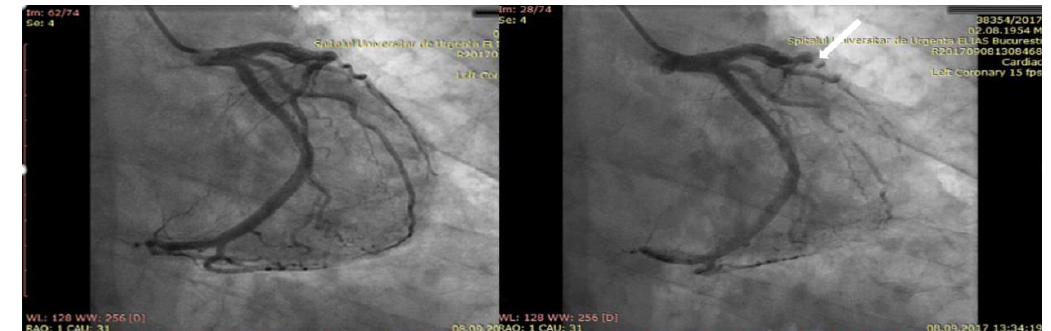
Figure 3. Diagnostic coronary angiogram. The coronary angiogram reveals no apparent coronary lesions. The white arrow indicates myocardial bridging on the medial segment of the left anterior descending.